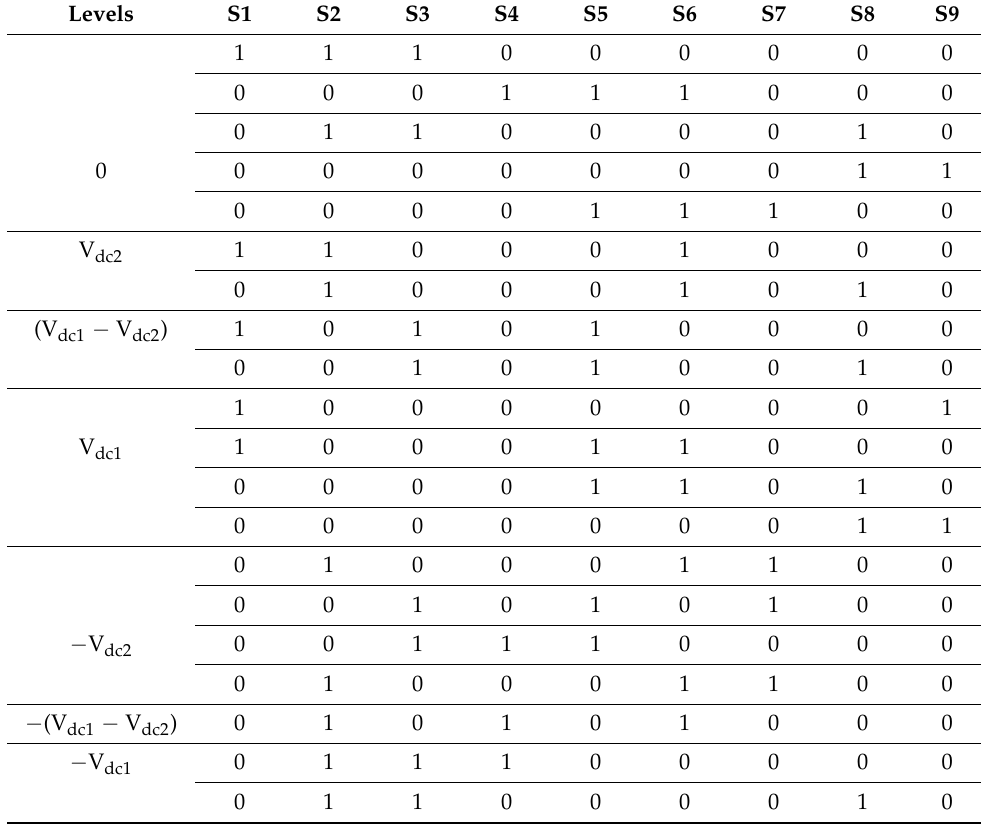
Figure 2. Proposed five-level fault-tolerant topology. Table 2. Switching table of proposed five-level fault-tolerant